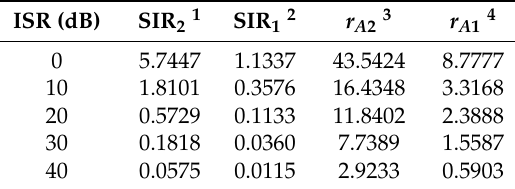
Table 2. The quantitative results for retransmitting deception jamming suppression.